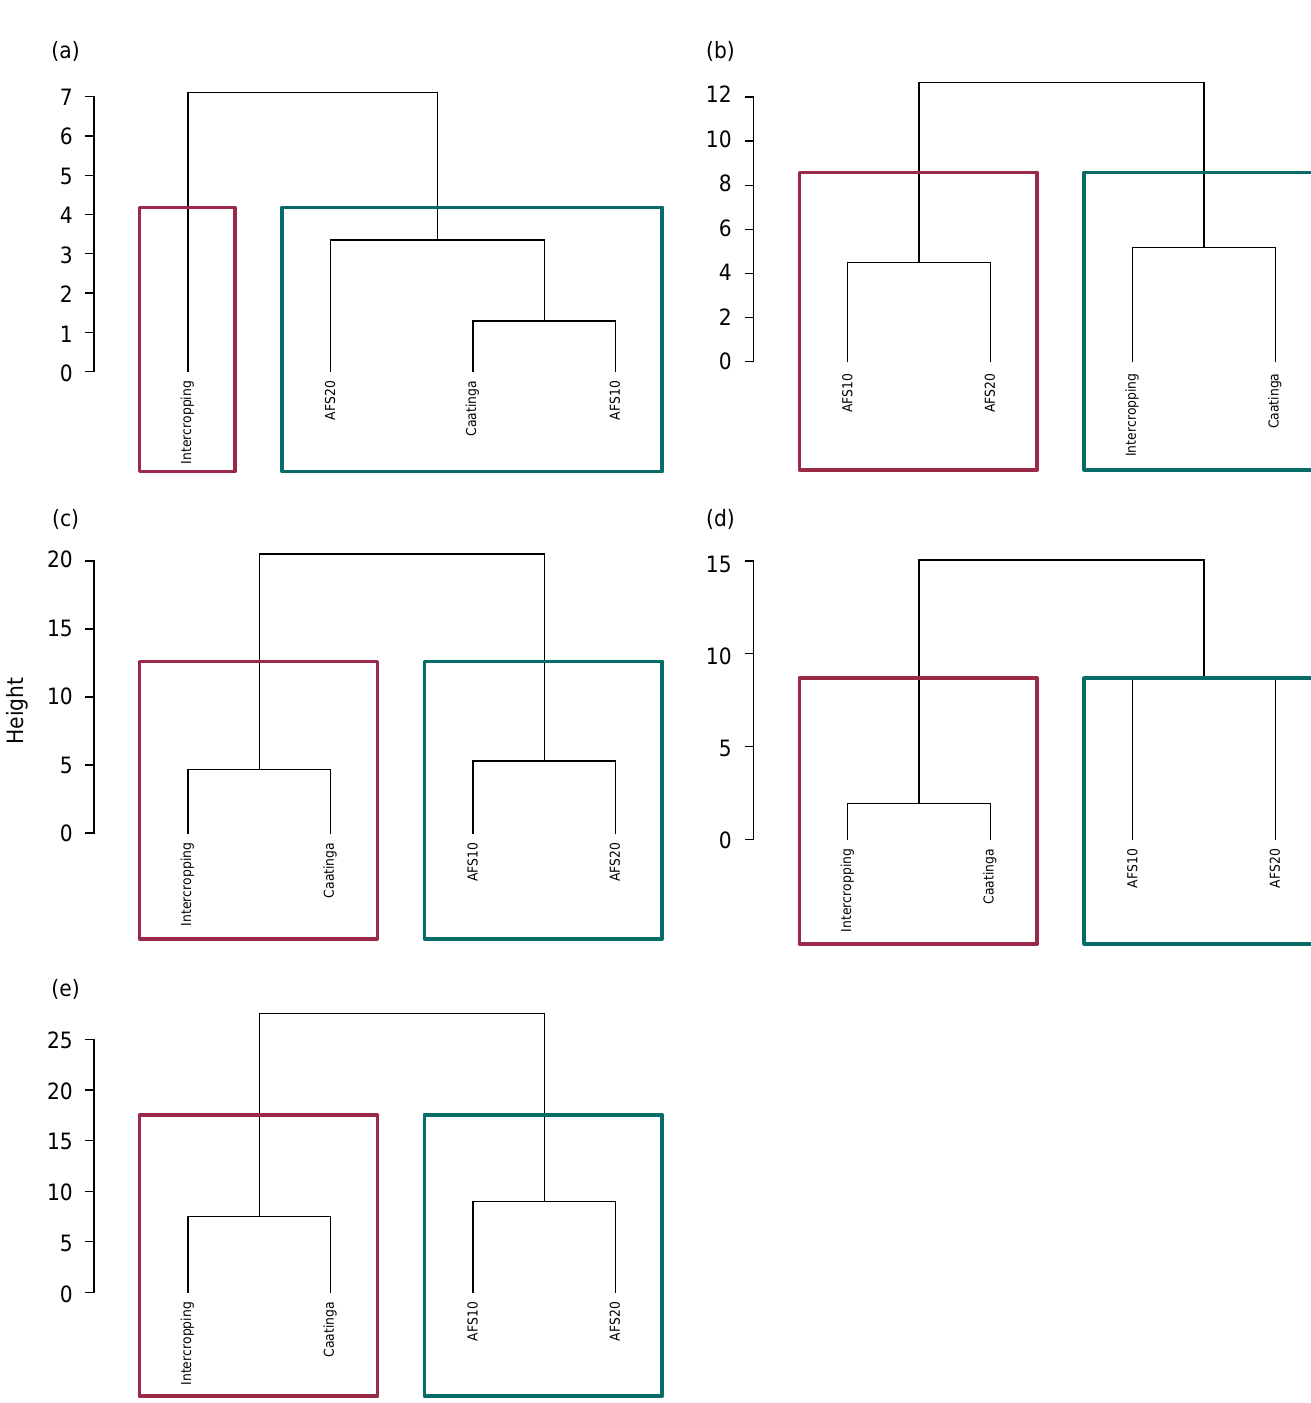
Figure 3. Dendrogram of dissimilarity between carbon and nitrogen contents and stocks, C/N ratio, and soil bulk density under agriculture managements Intercropped, Caatinga and agroforestry systems (AFS10 and AFS20) at 0.00-0.10 m (a), 0.10-0.20 m (b), 0.20-0.40 m (c), 0.40-0.60 m (d) and 0.60-1.00 m (e) soil layers. AFS10: Agroforestry with strips of native forest 10 m wide; AFS20: Agroforestry with strips of native forest 20 m